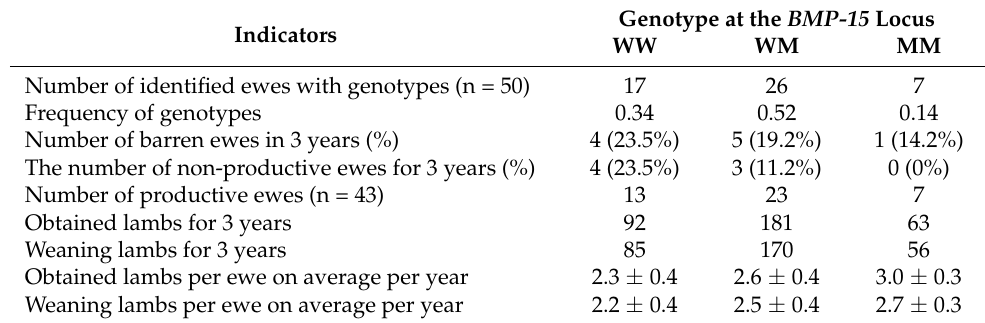
Table 3. Characteristics of ewes with different genotypes of the BMP-15 locus. Out of 52 animals studied, 2 were sires. Indicators